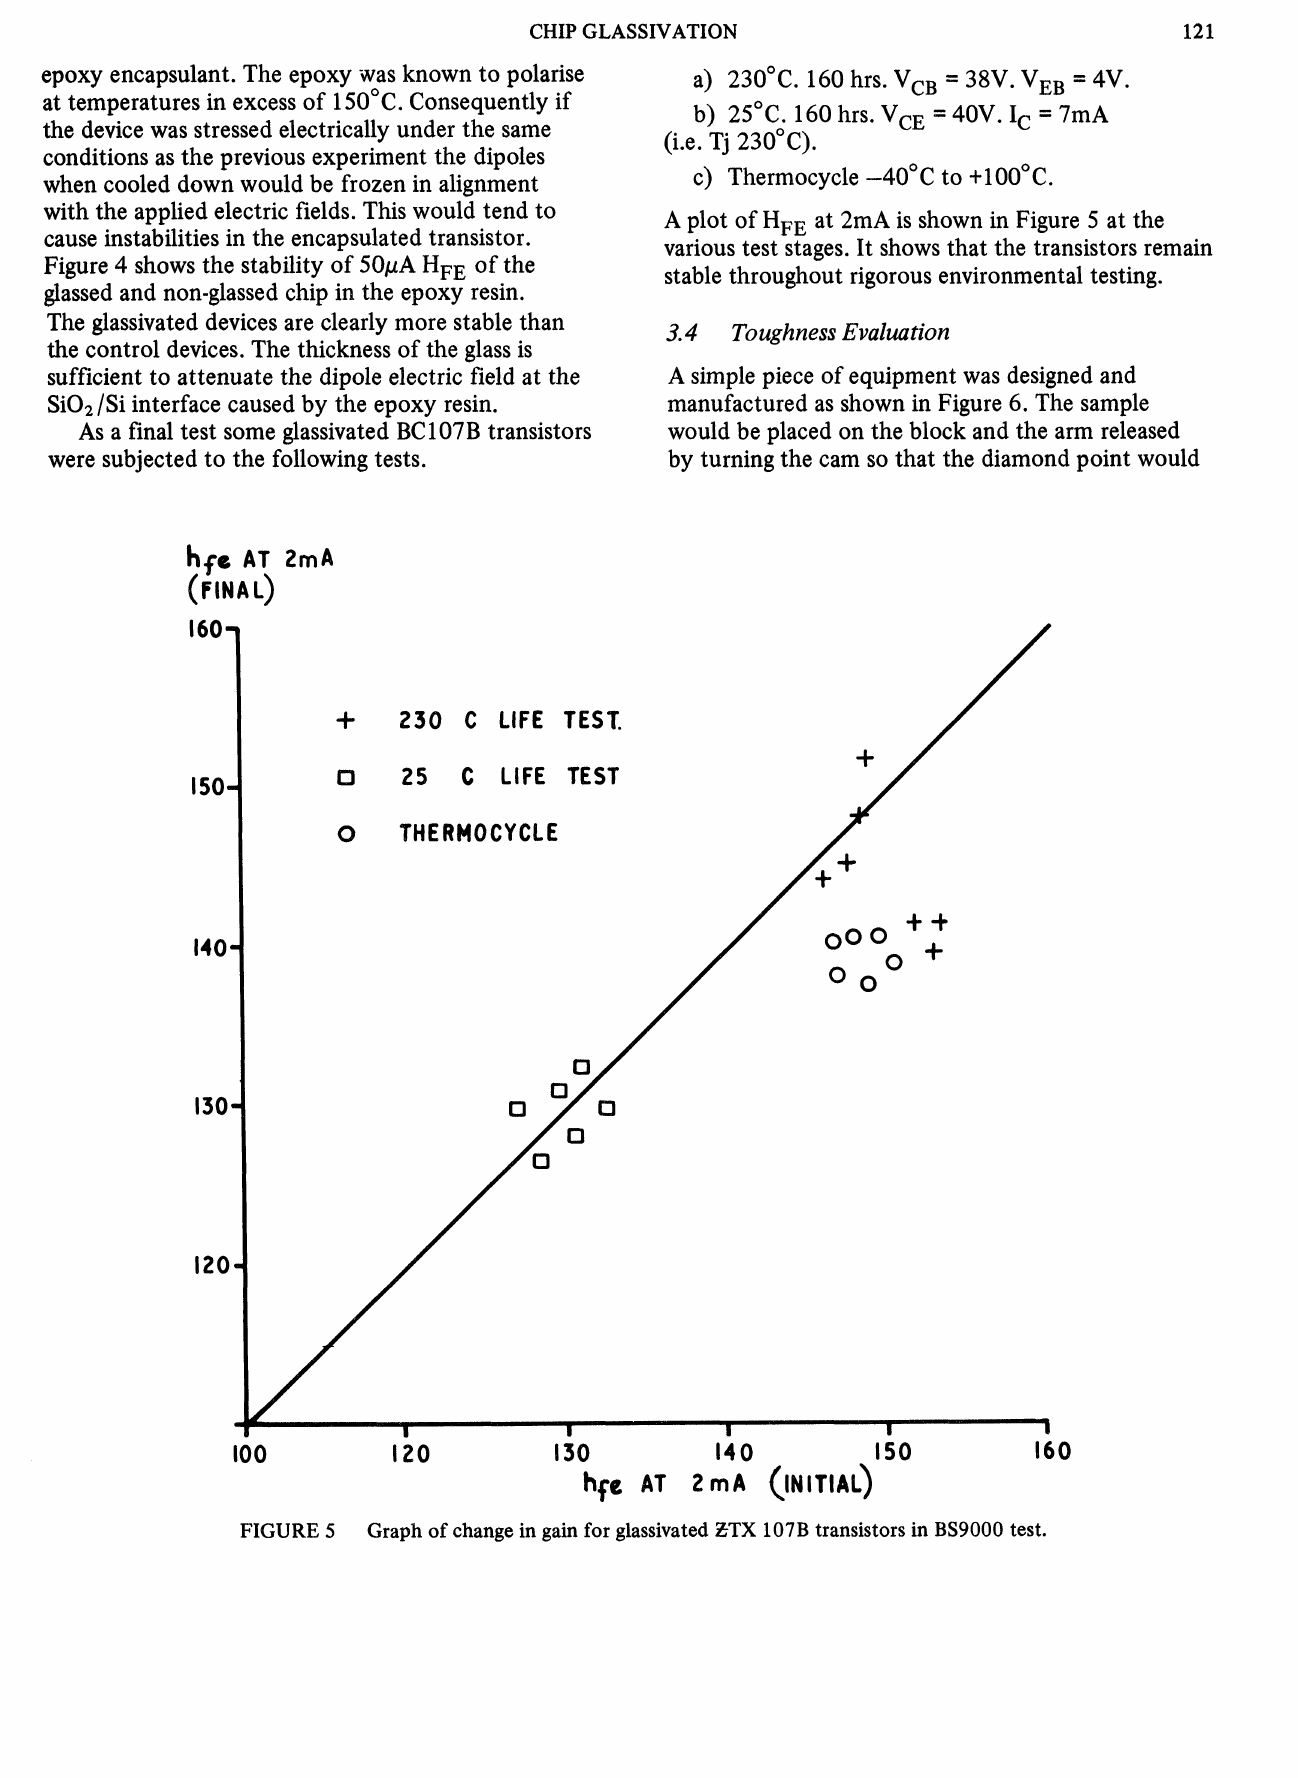
FIGURE 5 Graph of change in gain for glassivated ZTX 107B transistors in BS9000